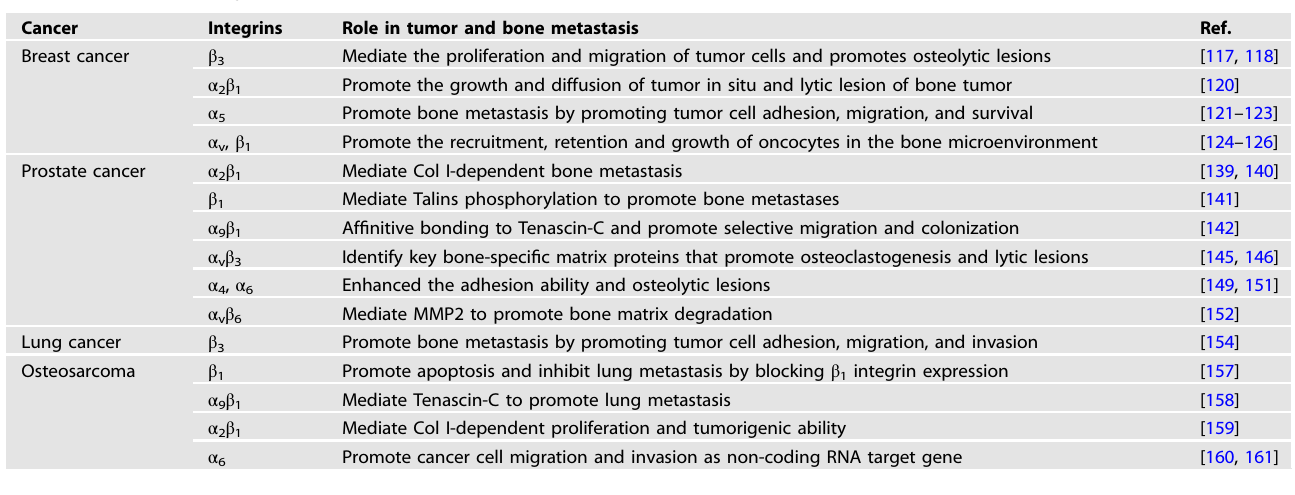
Table 2. The role of integrins in bone metastases of different cancers.